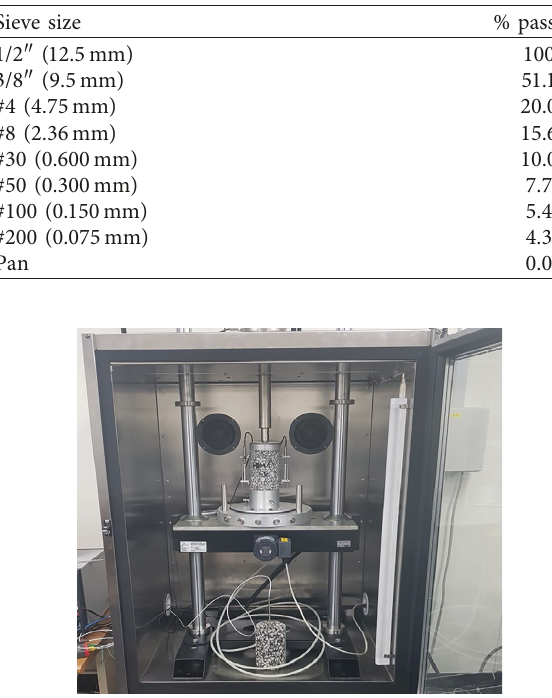
Table 1: Gradation used for the mixture.